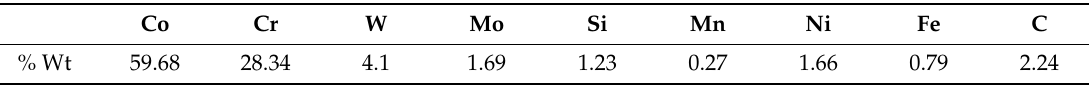
Table 1. Chemical composition values of Stellite 6 determined by EDX measurement and verified as identical to nominal composition (mass %).